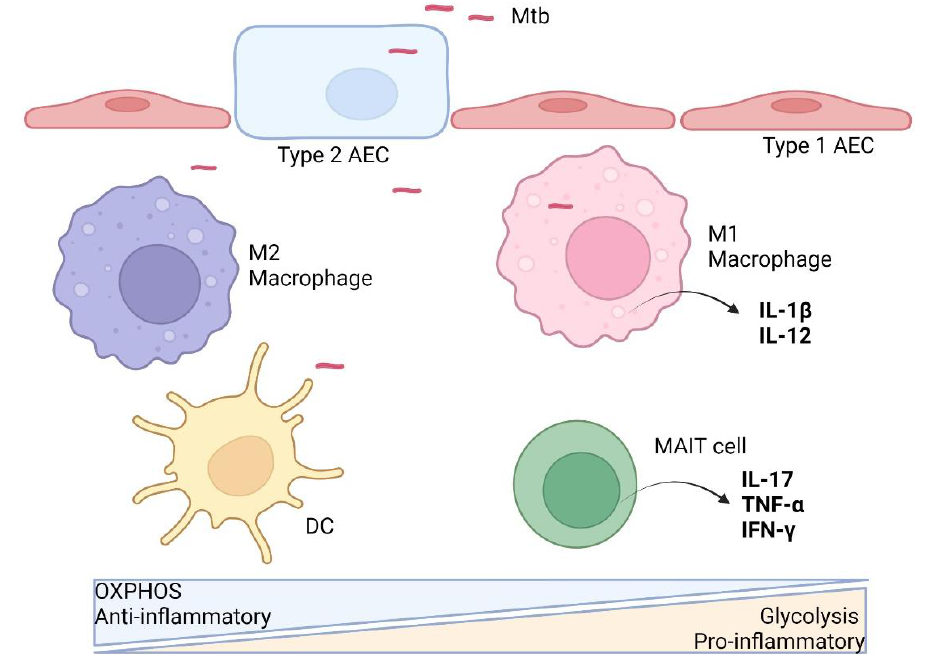
Figure 1. Innate immune cell immunometabolism against Mtb. After aerosol infection and successful breach of the alveolar epithelial cells (AEC), Mtb is taken up by resident alveolar macrophages (M2) and interstitial dendritic cells (DC), which predominantly rely on oxidative phosphorylation (OXPHOS) metabolism at the basal state without anti-microbial activities. Upon stimulation, the macrophage is activated, switching to aerobic glycolysis metabolism and a pro-inflammatory M1 phenotype, with the release of cytokines (e.g., IL-12) to activate more immune cells. Resident MAIT cells may also get activated upon Mtb infection with enhanced glycolytic metabolism and anti-microbial phenotype. Activated DCs migrate to draining lymph nodes to activate T cells. (Illustration created with BioRender.com, accessed on 19 June 2022).